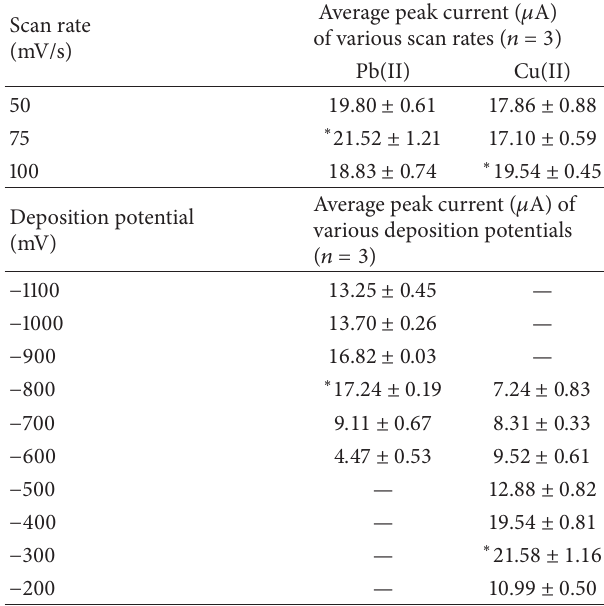
whereas the blank electrode produced no current response from − 1100 mV to +1200 mV (versus Ag/AgCl) (Figure 1). The potential window of Acetabularia -CPE ranged from − 700 mV to +900 mV.